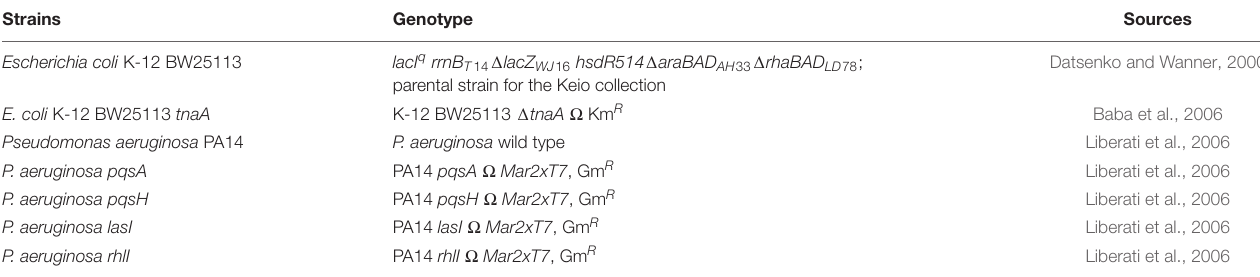
TABLE 1 | Strains used as host cells in this